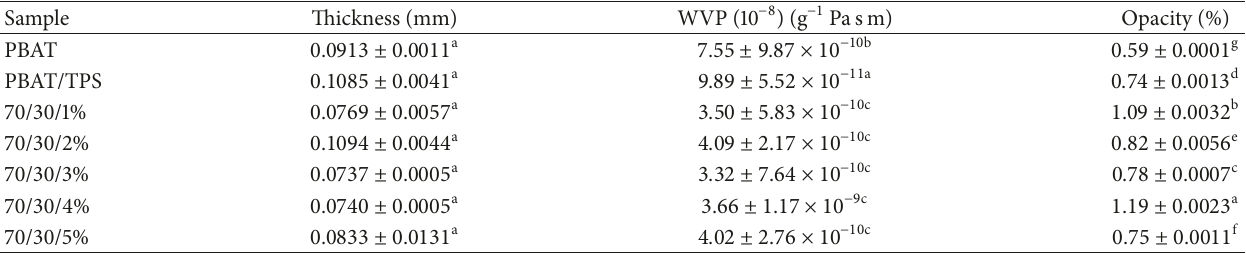
Table 1: Values of thickness, water vapor permeability (WVP), and opacity of the films.